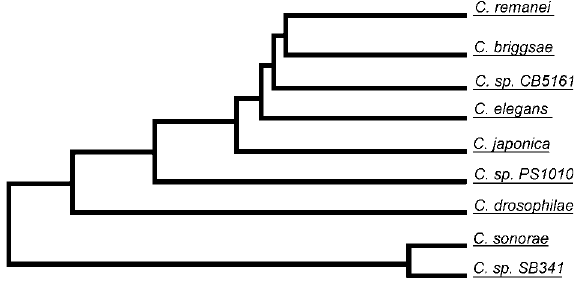
Figure 8. Phylogeny of